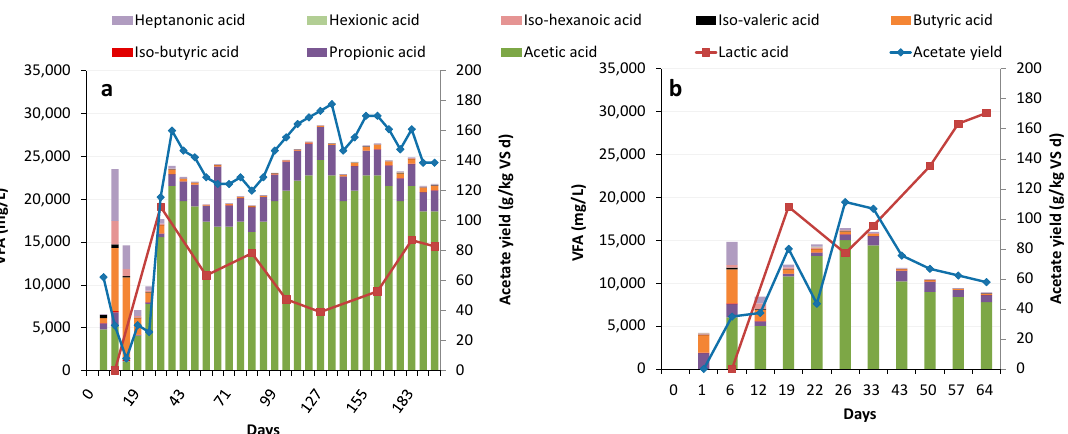
Figure 1. Volatile fatty acid (VFA) composition and acetate yield in reactors ( a ) CO-F (reactor inoculated from co-digestion plant fed with food waste) and ( b ) WW-F (reactor inoculated from wastewater treatment plant fed with food waste).